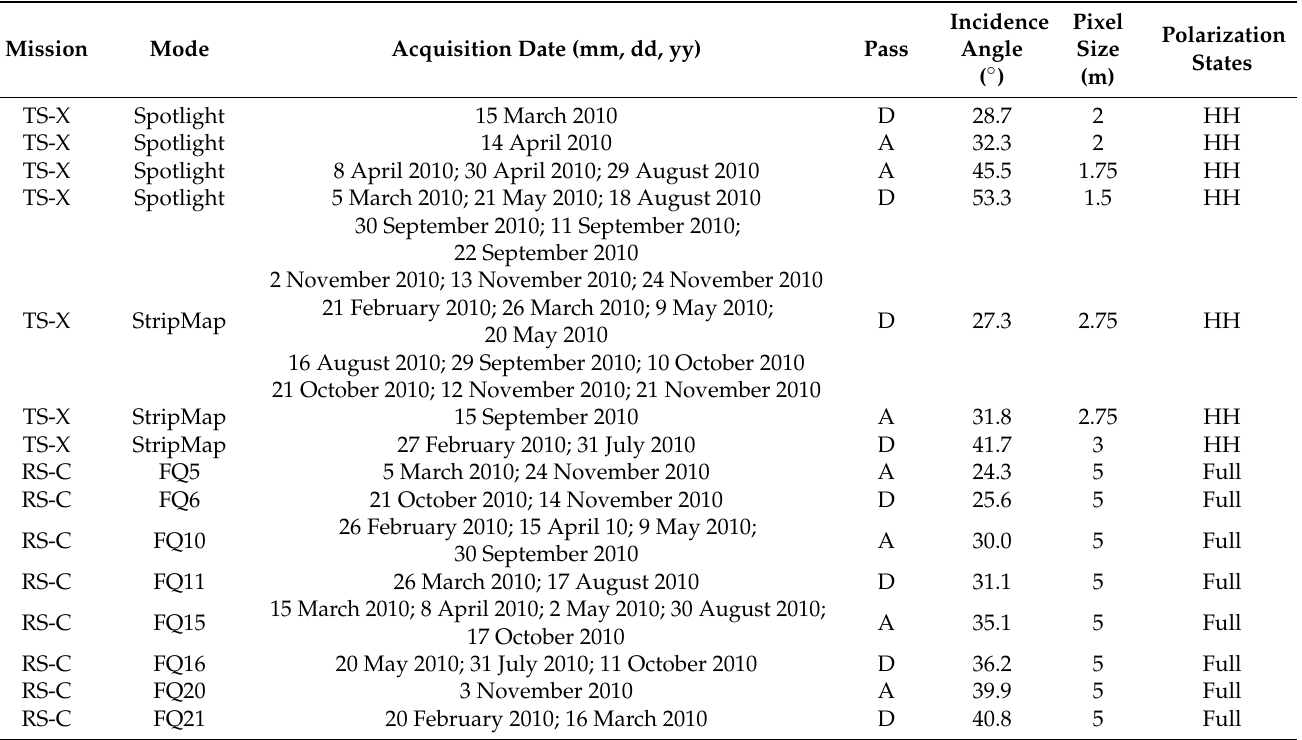
Table 2. Mean features of the TerraSAR-X and Radarsat-2